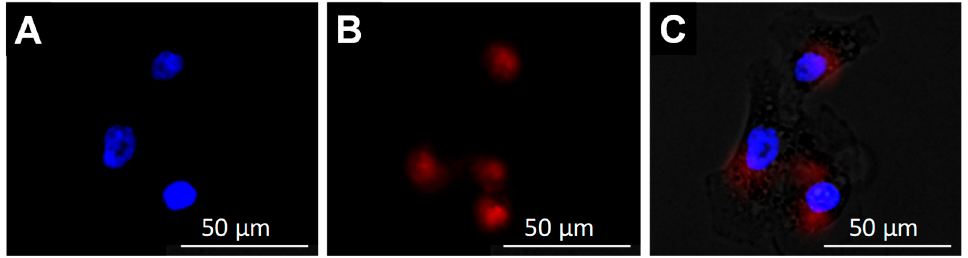
Figure 5. Fluorescence microscopy images of DU145 cells demonstrating intracellular localization of ZnMn-IONCs loaded with a near-infrared (NIR) dye, SiNc: ( A ) DAPI staining, ( B ) SiNc-ZnMn-IONCs and ( C ) overlay.